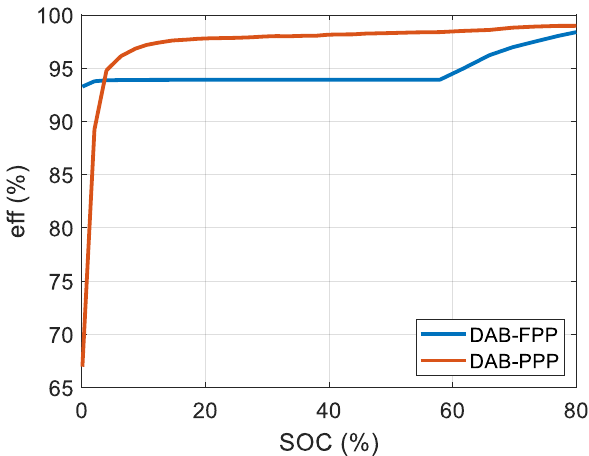
Figure 10. Efficiency comparison between the DAB-FPP and the DAB-PPP.